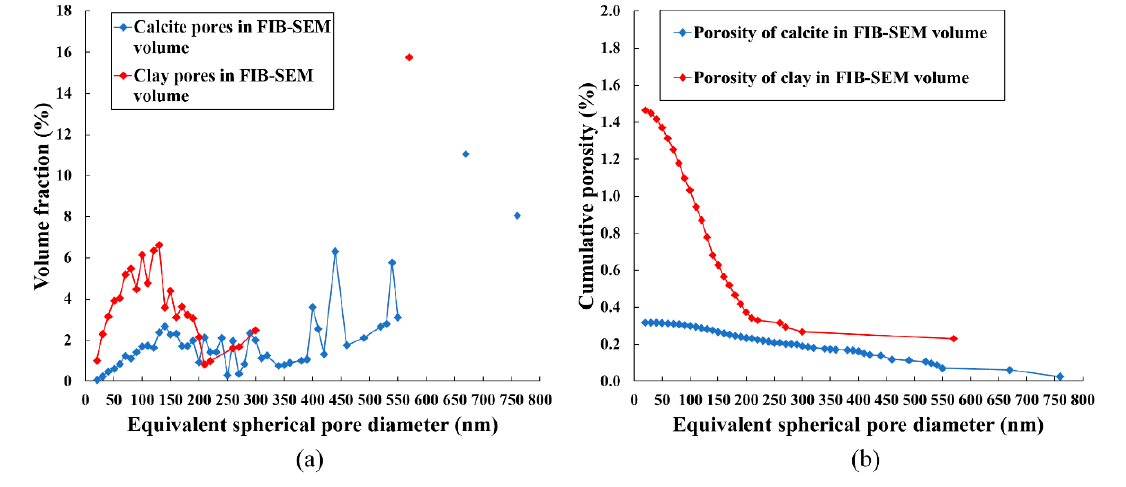
Figure 11. Conts